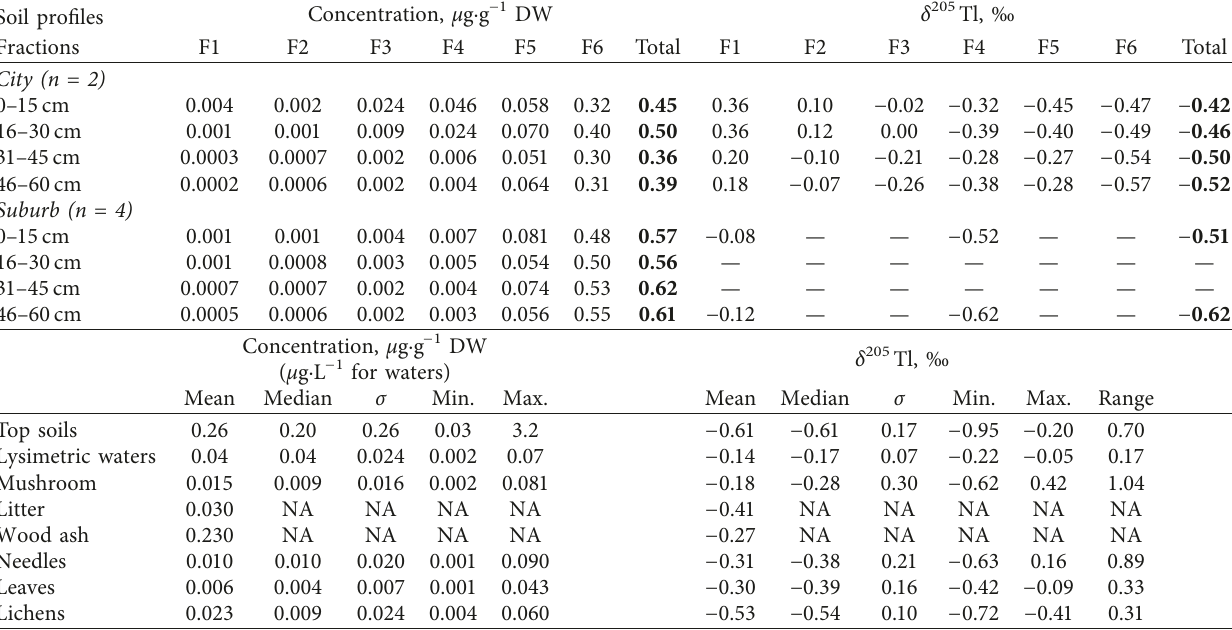
Table 11: Thallium concentrations and isotopic composition in environmental samples from Lule˚a. Soil